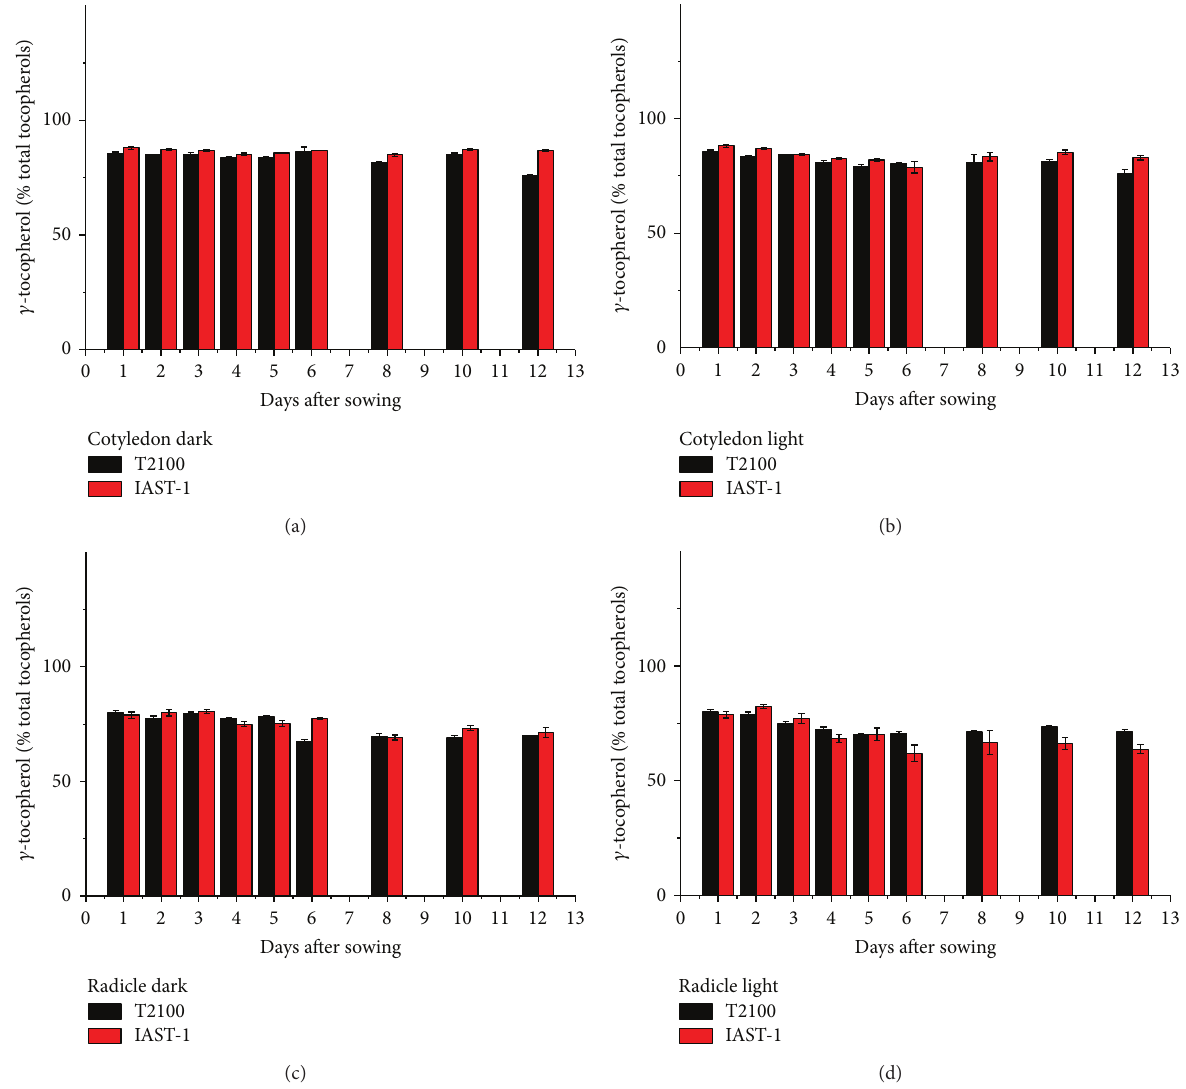
Figure 6: Proportion of 𝛾 -tocopherol (% total tocopherols) from 1 to 12 days after sowing in cotyledons and radicles of sunflower lines T2100 and IAST-1, with seed tocopherol content predominantly in the 𝛾 -tocopherol form, from seedlings grown under dark and light conditions. Data are presented as mean ± standard error of three